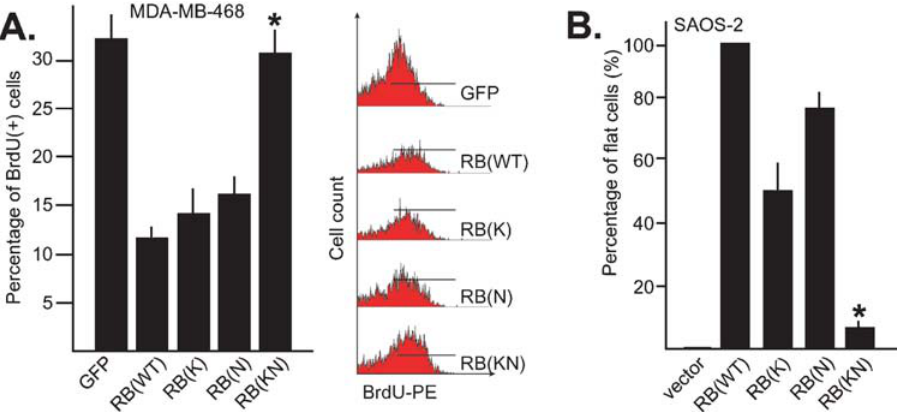
Figure 3. Growth suppression activity of the RB mutants. A) BrdU incorporation. MDA-MB468 cells were infected with the indicated recombinant adenoviruses encoding each of the indicated proteins. Infected cells were allowed to incorporate BrdU over a period of 14 hours before they were fixed and stained with phycoerythrin (PE)-conjugated monoclonal antibody against BrdU. The fraction of BrdU-positive cells in each sample was measured by flow cytometry (FACS). The levels of BrdU incorporation in GFP-virus and RB-KN-virus infected cells were statistically similar by student t - test (*) from three independent experiments. Representative FACS profiles with the BrdU-positive gates shown are displayed to the right of the histogram. B) Flat cell formation. SAOS-2 cells transfected with plasmids expressing neomycin resistance and each of the indicated RB proteins were cultured in G418 for two weeks. The giant flat cells were stained with crystal violet and their numbers counted under a dissection microscope. The number of flat cells induced by RB in each of four independent experiments was set at 100%. The means and standard errors of relative flat cell induced by vector, RB-K, RB-N and RB-KN from four experiments are shown. Student t -test showed the number of flat cells found in RB-KN-transfected cultures was significantly different (* p , 0.002) from that in RB-transfected cultures.